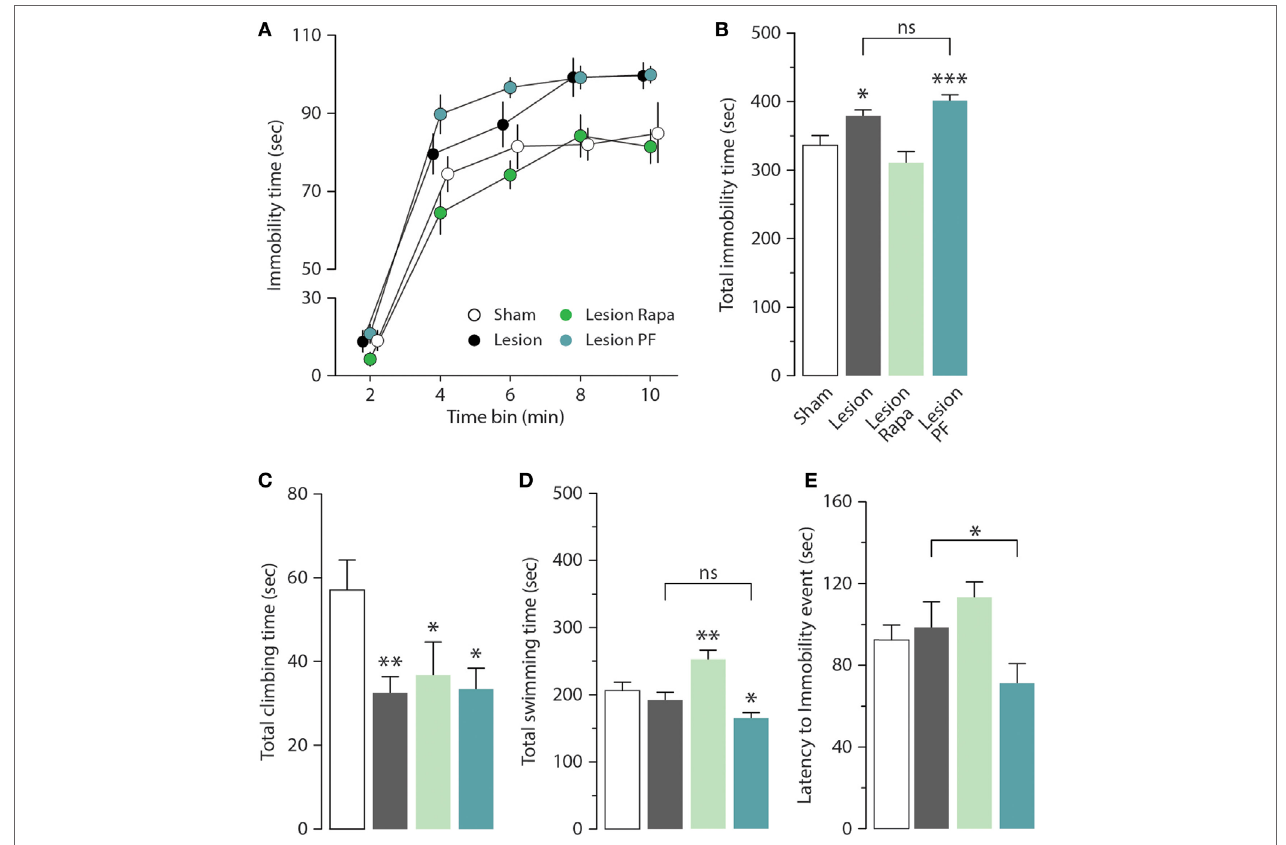
FigUre 2 | Rapamycin reverts depression-like behavior in a mouse model of Parkinson’s disease. Immobility time in the forced swim test (FST) was measured in Sham ( n = 12), and Lesion mice treated with vehicle ( n = 12), rapamycin (Lesion Rapa, n = 12), or PF-4708671 (Lesion PF, n = 12). (a) Time course (2 min bins) over the 10 min FST test. Repeated measures two-way ANOVA followed by Holm–Sidak’s post hoc indicated a significant difference p = 0.02 for Lesion vs. Sham and p = 0.0006 for Lesion PF vs. Sham. (B) Total immobility time (s) during the 10-min FST test. * p = 0.01 and *** p = 0.0002 vs. Sham (one-way ANOVA followed by Fisher’s post hoc comparison). (c) Total time (s) spent climbing. * p = 0.03 and 0.01, ** p = 0.007 vs. Sham (one-way ANOVA followed by Fisher’s post hoc test). (D) Total time (s) spent swimming. * p = 0.01, ** p = 0.006 vs. Sham (one-way ANOVA followed by Fisher’s post hoc comparison). (e) Latency (s) to first immobility event. * p = 0.04 Lesion vs. Lesion PF (one-way ANOVA followed by Fisher’s post hoc comparison). Data are presented as mean ± SEM. Groups and treatments are as indicated in